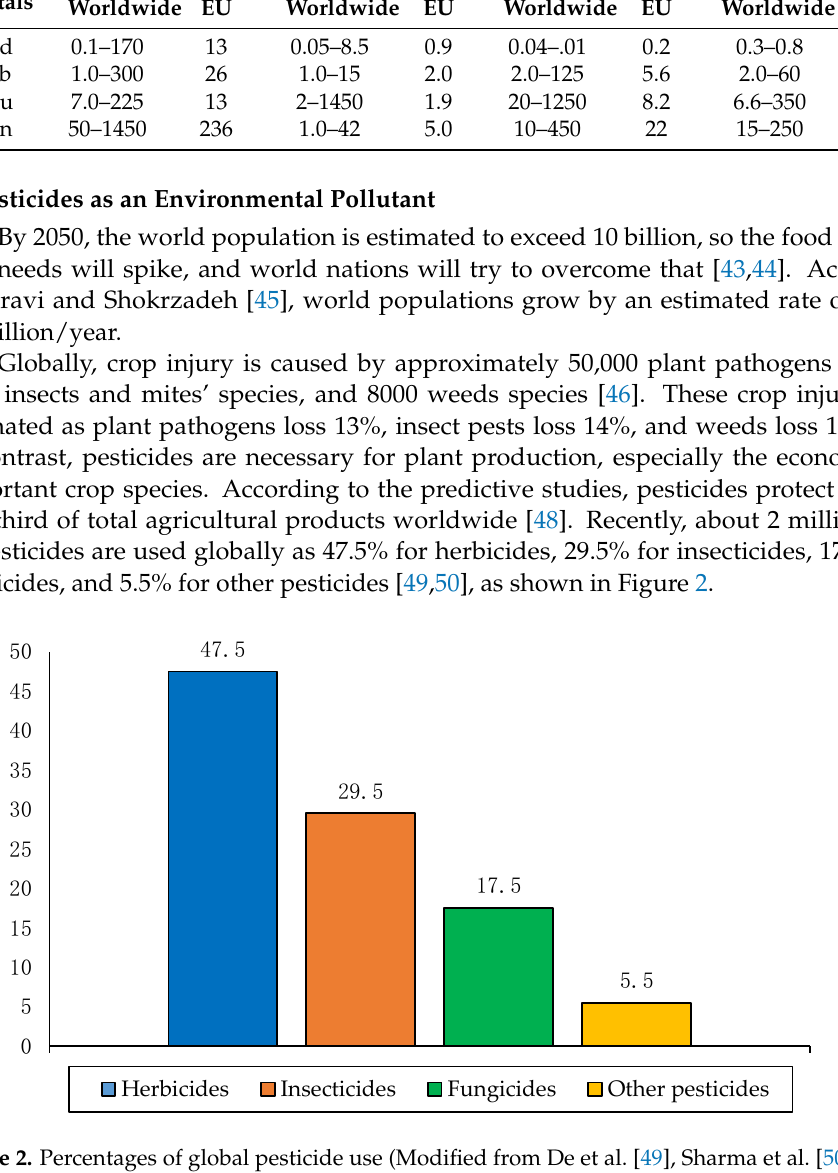
Figure 2. Percentages of global pesticide use (Modified from De et al. [49], Sharma et al. [50]). Globally, the top-ranked pesticide consuming countries are China, followed by the USA, Argentina, Thailand, Brazil, Italy, France, Canada, Japan, and India [51]. Furthermore, Zhang [46] estimated that annual pesticide use would rise to 3.5 million tons globally in 2020. Moreover, he also estimated the total average of the annual pesticide usage (kg/ha) worldwide during 2010–2014, as presented in Figure 3. Japan was the highest with (18.94), while China (10.45), followed by Mexico (7.87), Brazil (6.166), Germany (5.123), France (4.859), UK (4.034), USA (3.886), and finally, India with the smallest value